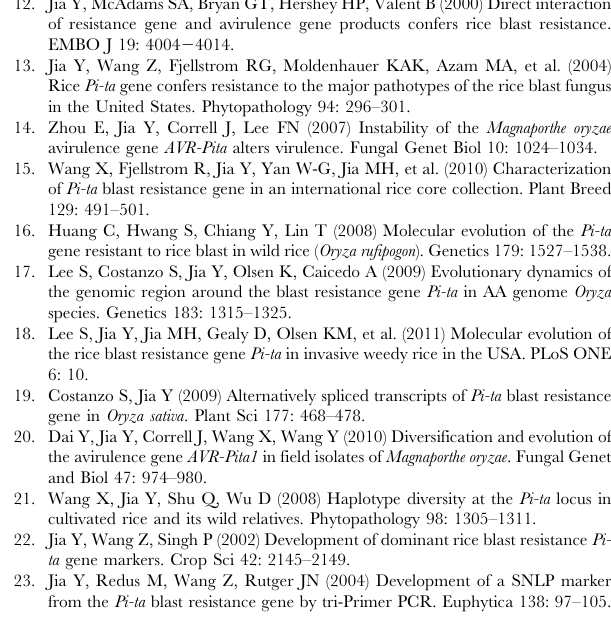
Table S1 Note to mapping population. Table S2 Mapping profile for Early Katy mapping population for JoinMap. Table S3 SSR marker file for Early and Katy mapping